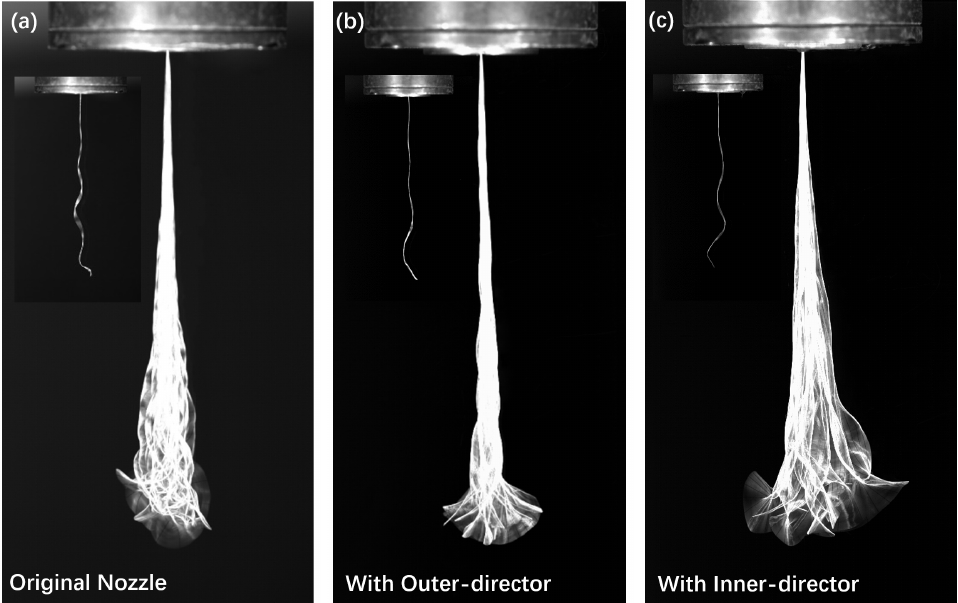
Figure 9. Overlapping of successive high-speed images of a filament fibre oscillation under the melt blowing slot-die nozzle: ( a ) Original nozzle, ( b ) nozzle with outer-director, and ( c ) nozzle with inner-director.